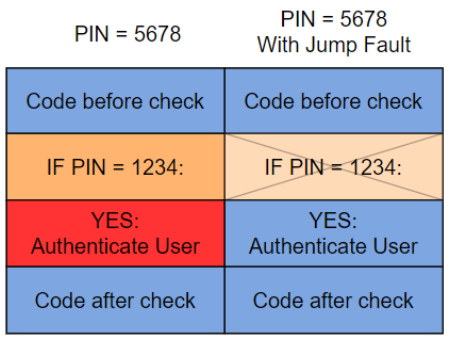
Figure 2. Instruction Skip in Pin Verification Software.